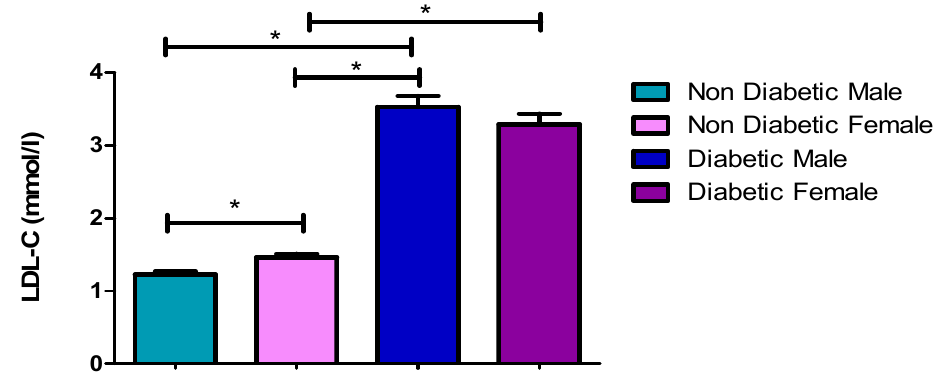
Figure 4. Low-density lipoproteins cholesterol (LDL-C) concentrations. *, a significant statistical